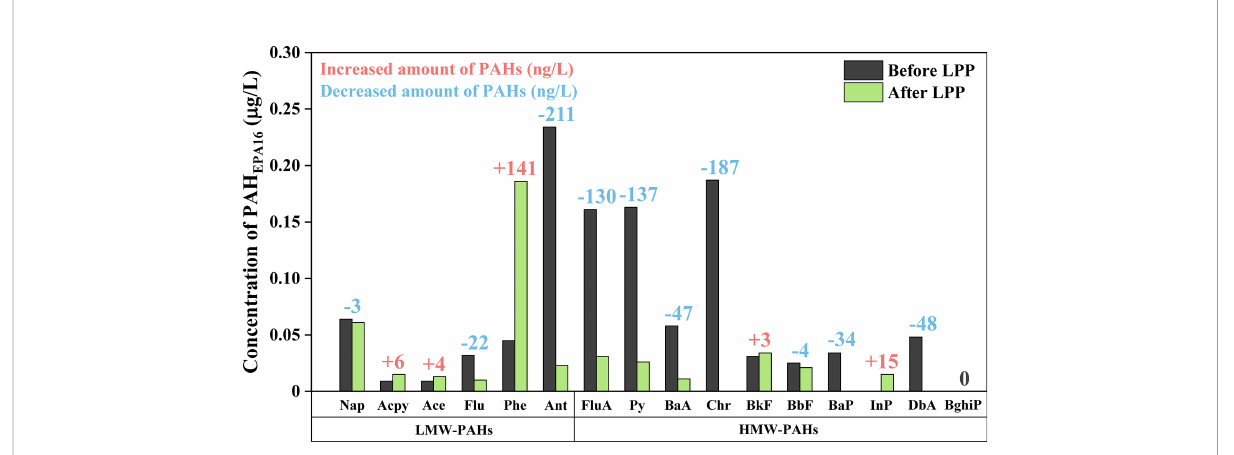
FIGURE 8 Concentration of PAH EAP16 in real scrubber ef fl uent before and after 10 min of the LPP treatment at a frequency of 30 kHz and a pulse width of 3 m s. Although a little amount of low molecular weight PAHs (LMW-PAHs) were produced due to incomplete combustion of PAHs or their byproducts, LPP showed great performance in degradation of high molecular weight PAHs